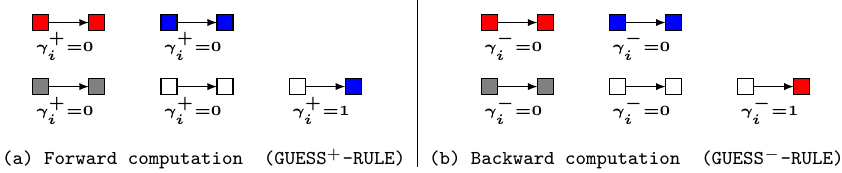
Figure 3: The rule of Guess in forward and backward